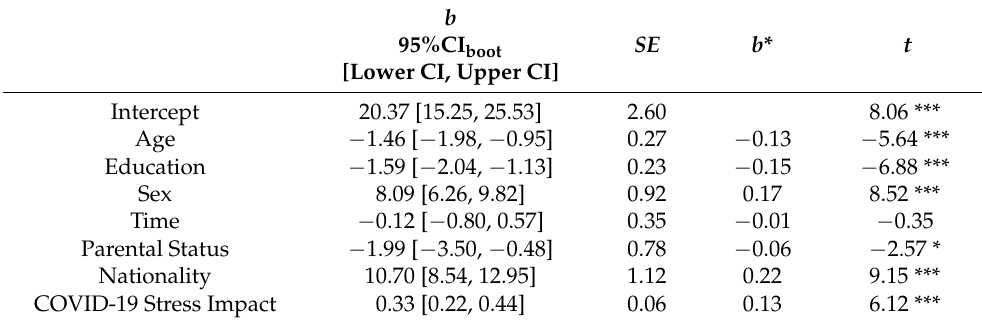
Table 3. Second step of the hierarchical linear regression of COVID-19 stress impact on traumatic